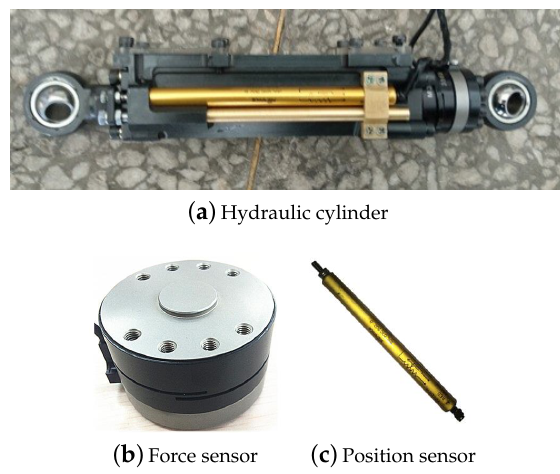
Figure 2. The hydraulic cylinder and sensors of the SCalf.